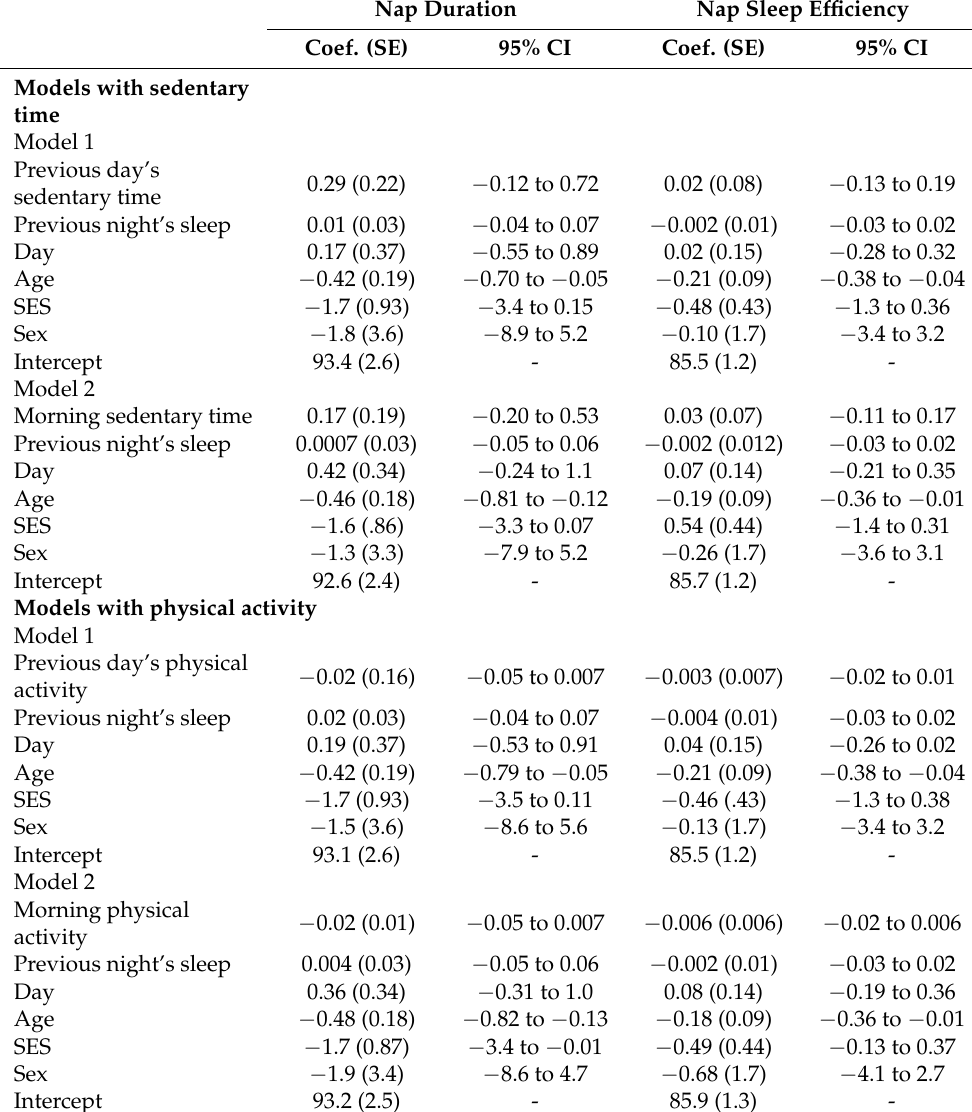
Table 3. Multilevel linear regression results for nap sleep measures. Nap Duration Nap Sleep Efficiency Coef. (SE) 95% CI Coef. (SE) 95%